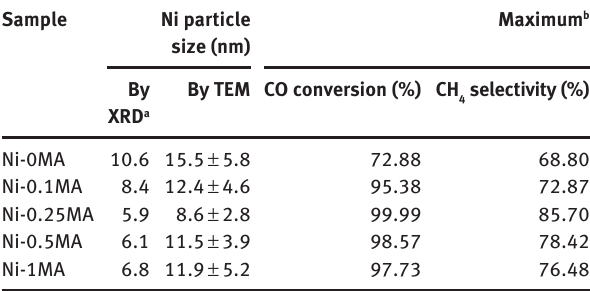
-TPD profiles of the catalysts. 2